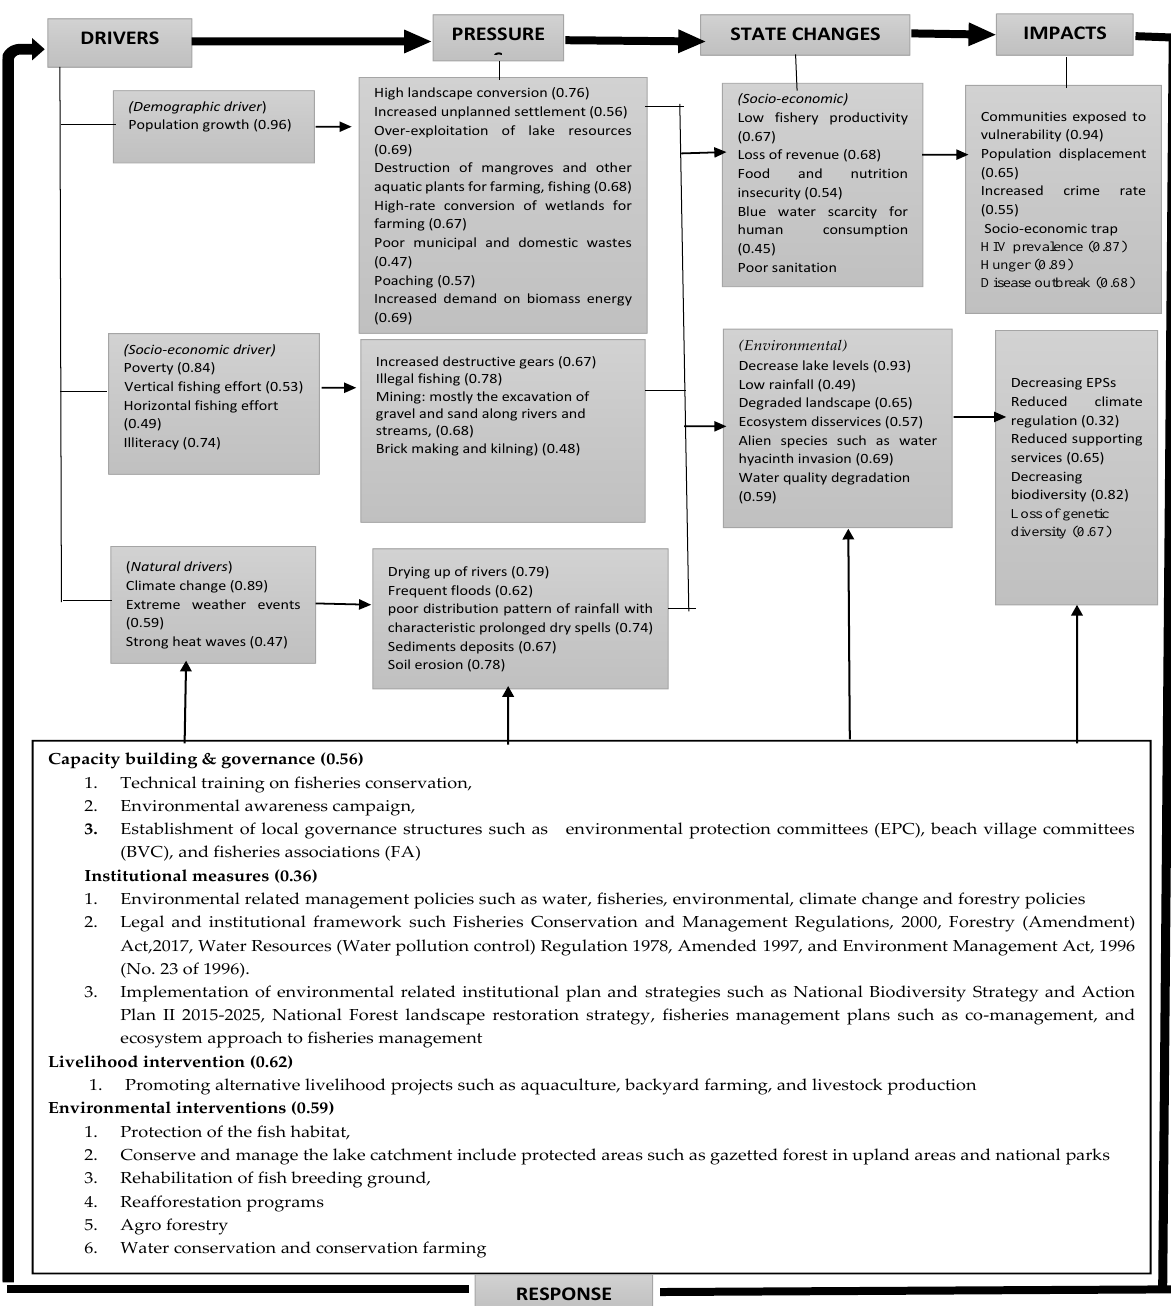
Figure 4-DPSIR model for Lake Malombe Inland freshwater shallow lake Figure 4. DPSIR model for Lake Malombe Inland freshwater shallow The stakeholders ranked rapid population growth as the highest indicator for the demographic driver (0.96). The pressure associated with this driver includes high land- scape conversion, increased unplanned settlement, over-exploitation of lake resources, de- struction of mangroves and other aquatic plants for farming, fishing, high-rate conversion